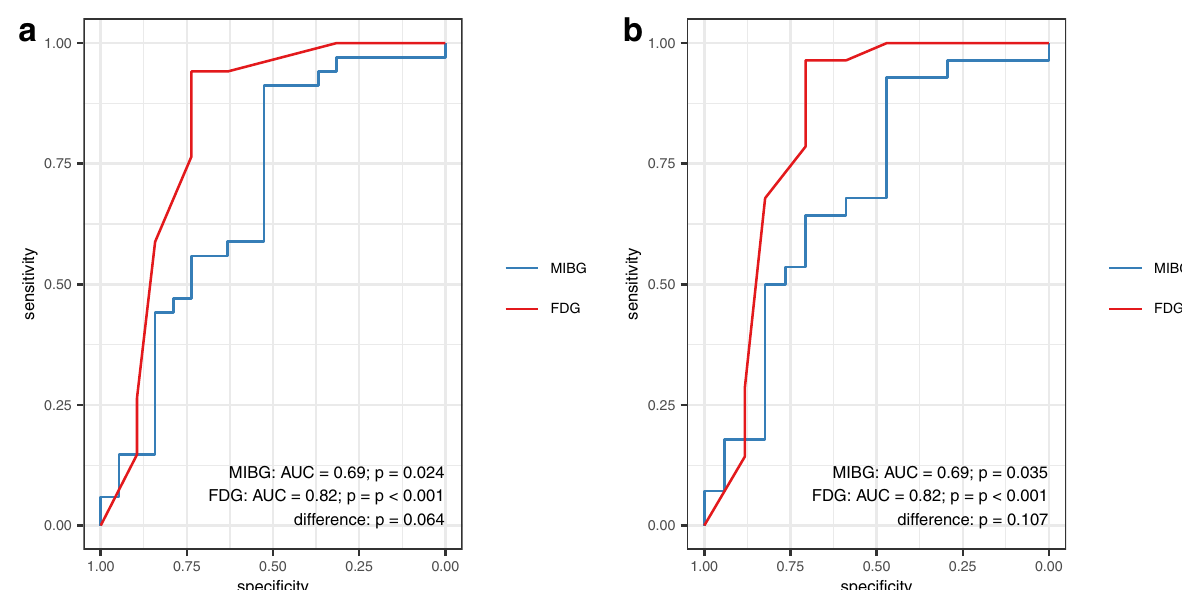
Fig. 2 Receiver operating characteristic curves. a Differentiation of Lewy body disease from diseases without Lewy bodies and b differentiation of Parkinson ’ s disease and multiple system atrophy. MIBG MIBG scintigraphy, FDG FDG positron emission tomography, AUC Area under the receiver operating characteristic